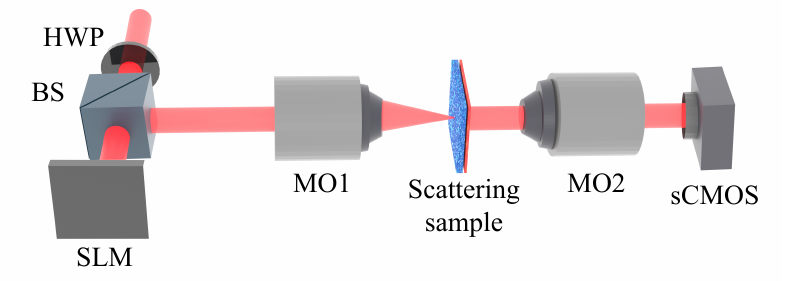
Figure 6. Schematic of the experimental setup. The expanded incident beam ( λ = 632.8 nm) passes through a half-wave plate (HWP) and a beam splitter (BS) to the spatial light modulator (SLM). From the SLM, the beam is focused onto the scattering sample by a microscope objective (MO1). The speckle is collected by MO2 and imaged by an sCMOS